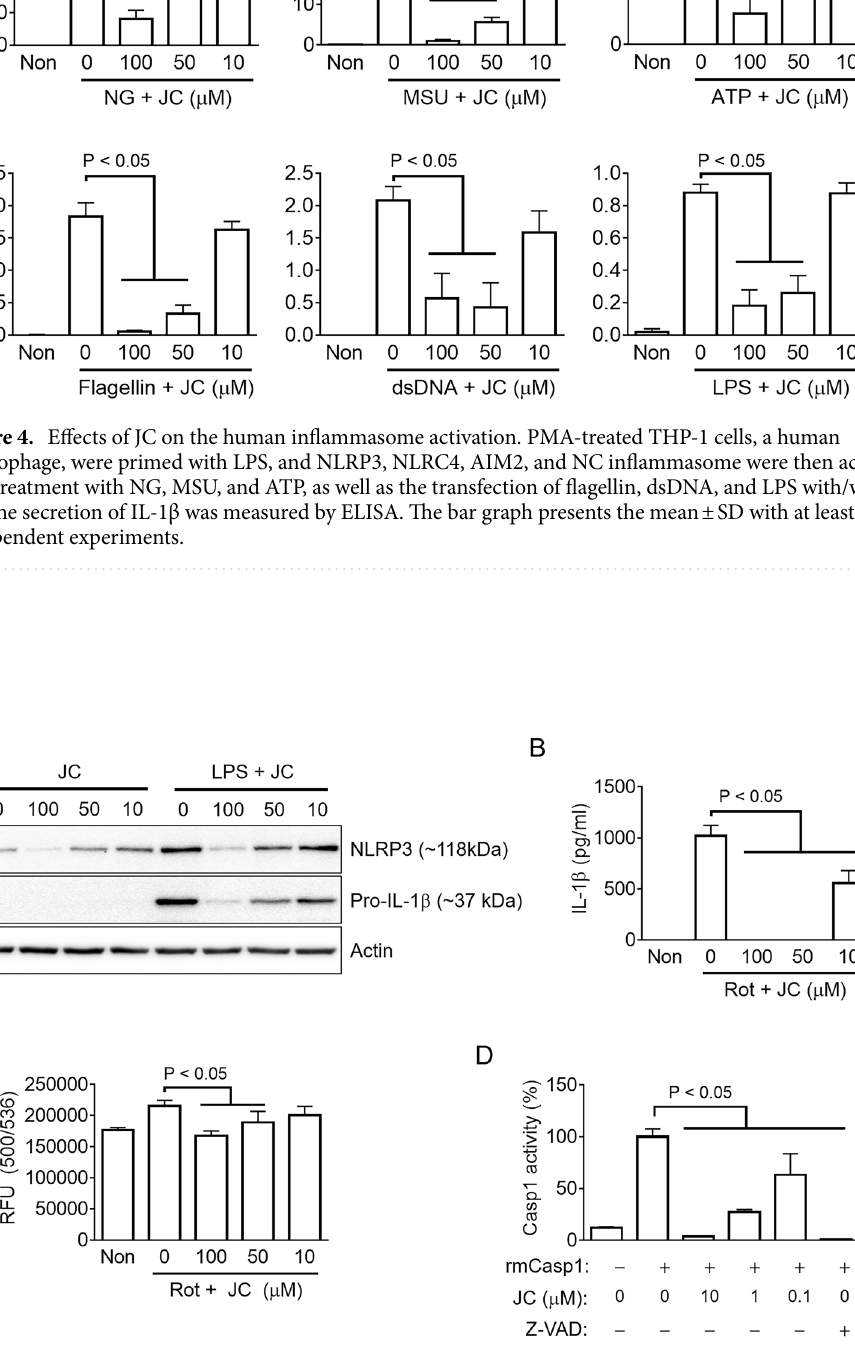
Figure 5. Mechanistic study of the anti-inflammasome property of JC. ( A ) BMDMs were treated with LPS (10 ng/ml) and JC for 3 h, and the protein levels of NLRP3 and pro-IL-1β were analyzed by immunoblotting. ( B ) LPS-primed BMDMs were treated with JC and rotenone (Rot), which led to mitochondrial ROS production. The IL-1β released was measured by ELISA. ( C ) LPS-primed BMDMs were treated with Rot and JC, and the ROS levels were then analyzed using a relative fluorescence unit (RFU, excitation at 505 nm, and emission at 536 nm). ( D ) The activity of recombinant mouse caspase-1 (rmCasp1) was measured using an assay kit in the presence of JC and Z-VAD-FMK (Z-VAD, pan-caspase inhibitor). The bar graph presents the mean ± SD with at least three independent